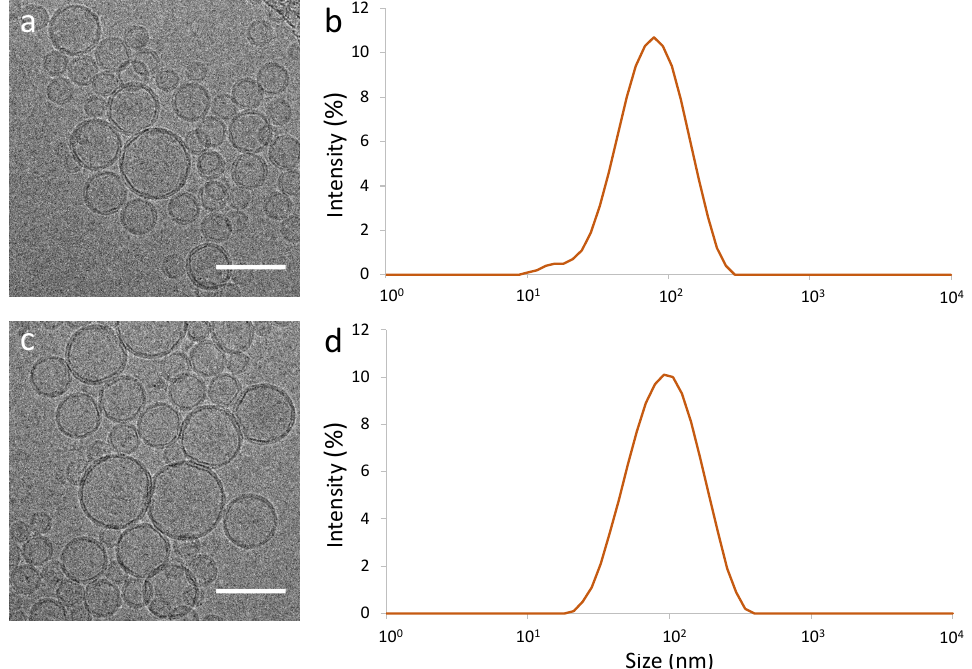
Figure 3. Characterisation of pure lipid SUVs ( a , b ) and integrin-containing pSUVs ( c , d ) by Cryo- Electron Microscopy (Cryo-TEM) (( a , c ), scale bars: 100 nm) and Dynamic Light Scattering (DLS) ( b , d ). At this resolution, the transmembrane protein is not visible in TEM. Table 2. Comparison of measured size of SUVs with integrins (pSUVs) or without (pure lipid SUVs), using cryo-TEM or DLS. The two types of SUVs have similar sizes, and the values obtained from the two techniques agree within the error bars. For TEM images, >100 individuals were measured. Error is standard deviation for cryo-TEM data and peak-width for DLS data. Cryo-TEM